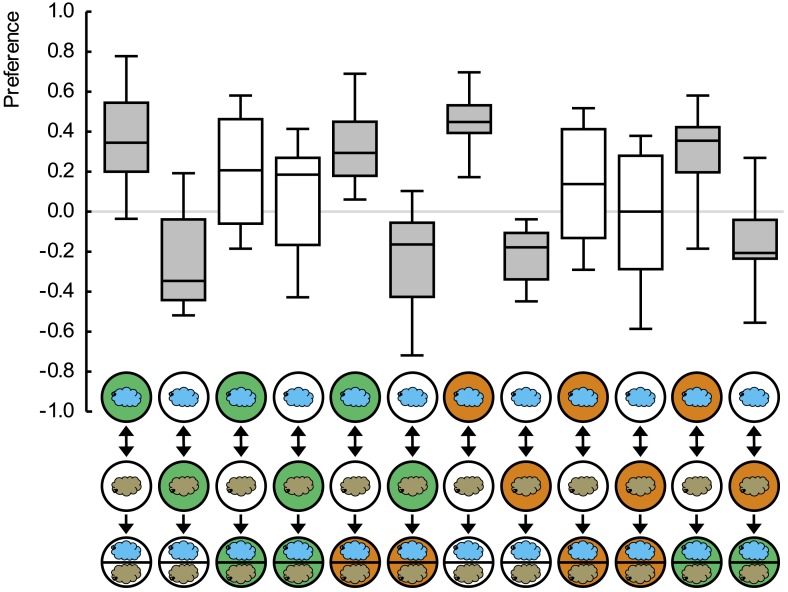
Preference scores for the reciprocally trained groups of Figure 1.Sample sizes: 15–19. Shaded boxes indicate pairwise differences between groups (p < 0.05/6, Mann–Whitney U-tests). For a detailed description of the sketches, see legend of Figure 1.